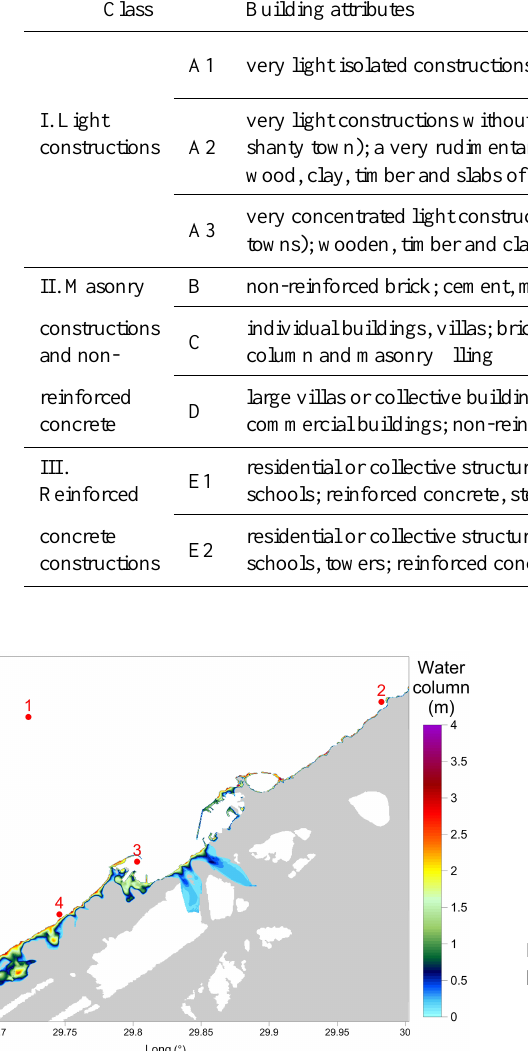
Figure 10. Water depth maxima on land for the EHA case plotted in grid 4 (40m resolution) in mean-sea-level conditions. See caption of Fig. 6 for further details.